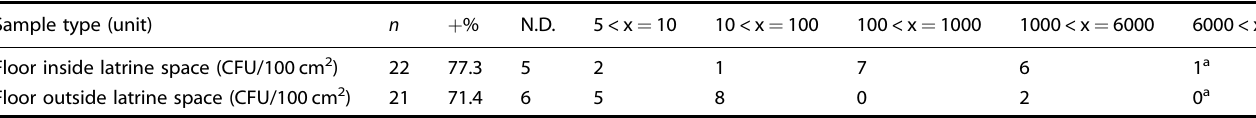
Table 1. E. coli concentration of fl oor surfaces inside and outside of pit latrines.